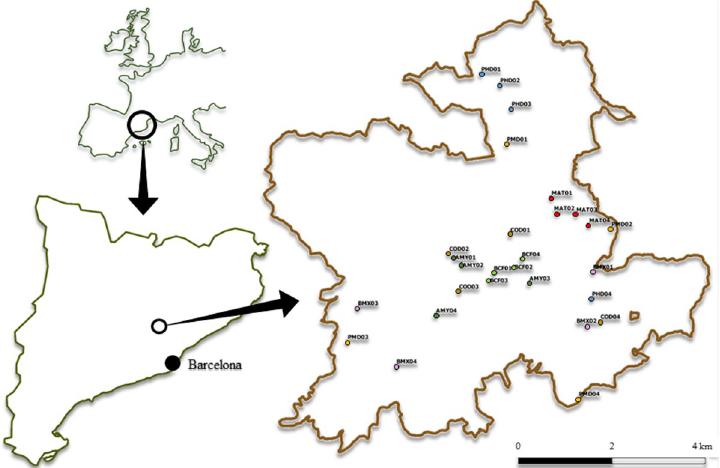
Fig 3. Location of the pilot study area. The geographic location of the Sant Lorenc¸ del Munt i l’Obac Natural Park (white ring) in the nearby of the metropolitan area of Barcelona (black ring) in Catalonia (NE Iberian Peninsula) and its perimeter. Squares correspond to 100 × 100m Permanent Monitoring Plots, where COD correspond to Rocky areas habitat, MAT: Shrublands; PMD: Mediterranean pine forests, PHD: Wet pine forests; BMX: Mixed forests, AMY: Mountain holm oak forests, and BCF: Deciduous forests.